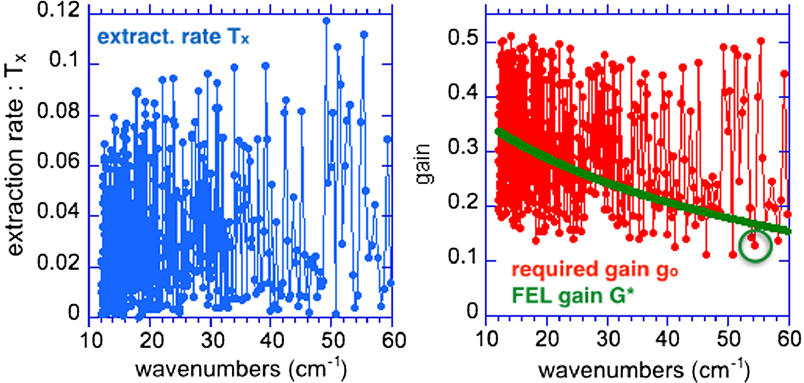
FIG. 7. Extraction rate T coefficient G (cid:3)